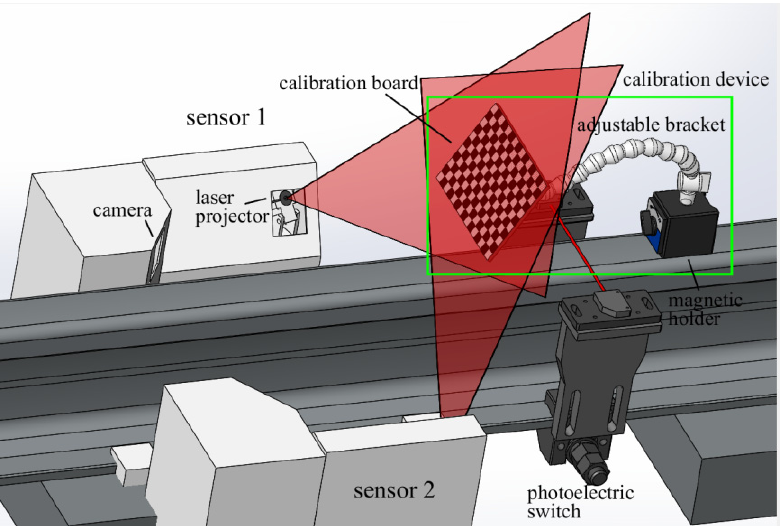
Figure 1. Schematic of the calibration process.